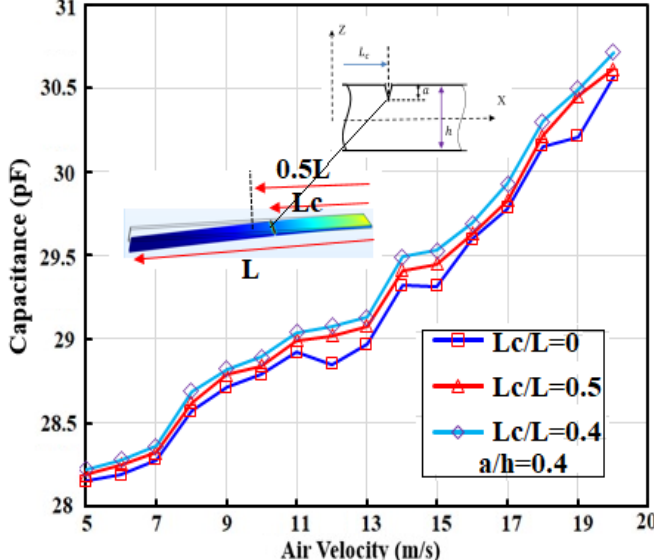
Figure 19. The capacitance output of a cracked microcantilever compared to uncracked MCL. The crack size (depth) is kept constant and its location along the microcantilever has been changed for two positions, Lc / L = 0.5 and Lc / L = 0.4 when the depth of V-shaped microcrack is 0.8 µm.